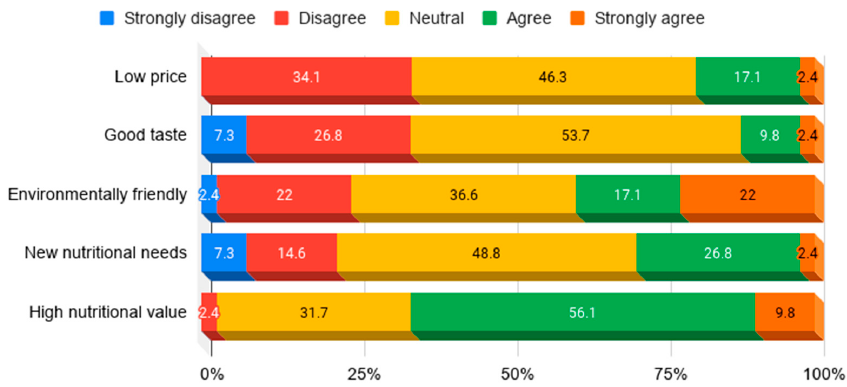
Figure 2. Reasons to supply insect medical foods to users.